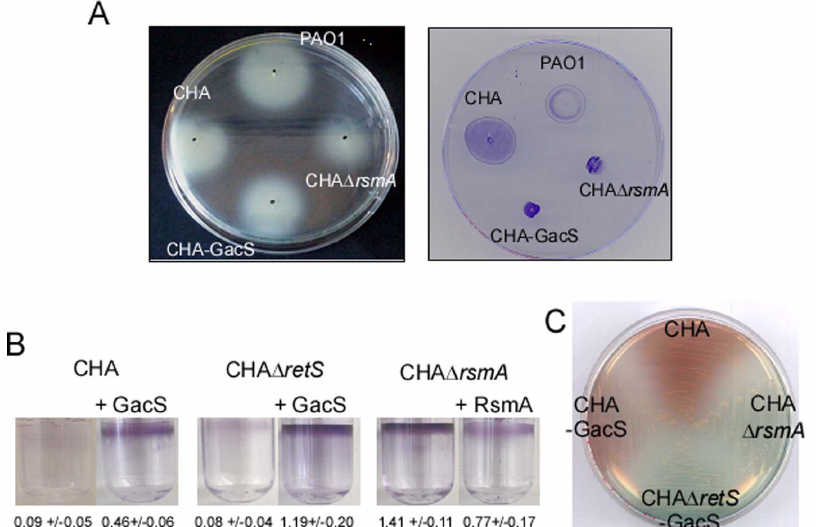
Figure 6. Impact of gacS inactivation in CHA on different virulence traits. (A) Swimming (left) and twitching (right) motilities of indicated strains. CHA-GacS contains the gacS gene amplified from PAO1 integrated into the chromosome. The images of the plates with regard to both the extent of spreading and morphology of motile bacteria are representative. (B) Air-liquid biofilm assay of indicated strains, containing either the empty plasmid (control) or the plasmid expressing the protein of interest, as indicated. For the assays with GacS, 0.5% arabinose was added in the medium. Biofilm was stained with crystal violet after 24 h at 30 u C and quantified. The means of each assay performed in quadruplicate and their standard deviation are indicated below the corresponding pictures. (C) Pigment production in CHA is strongly affected by rsmA mutation, and retS mutation when gacS is integrated into the chromosome, as observed on PIA plate.